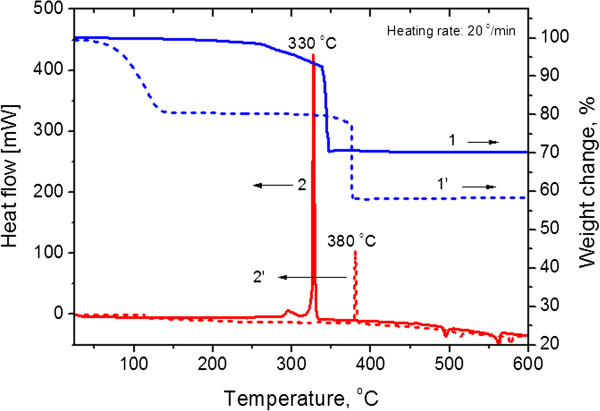
DSC-TGA curves of K2TaF7 + 5NaN3 and K2TaF7 + 9NaN3 + 4NH4F systems in argon atmosphere.